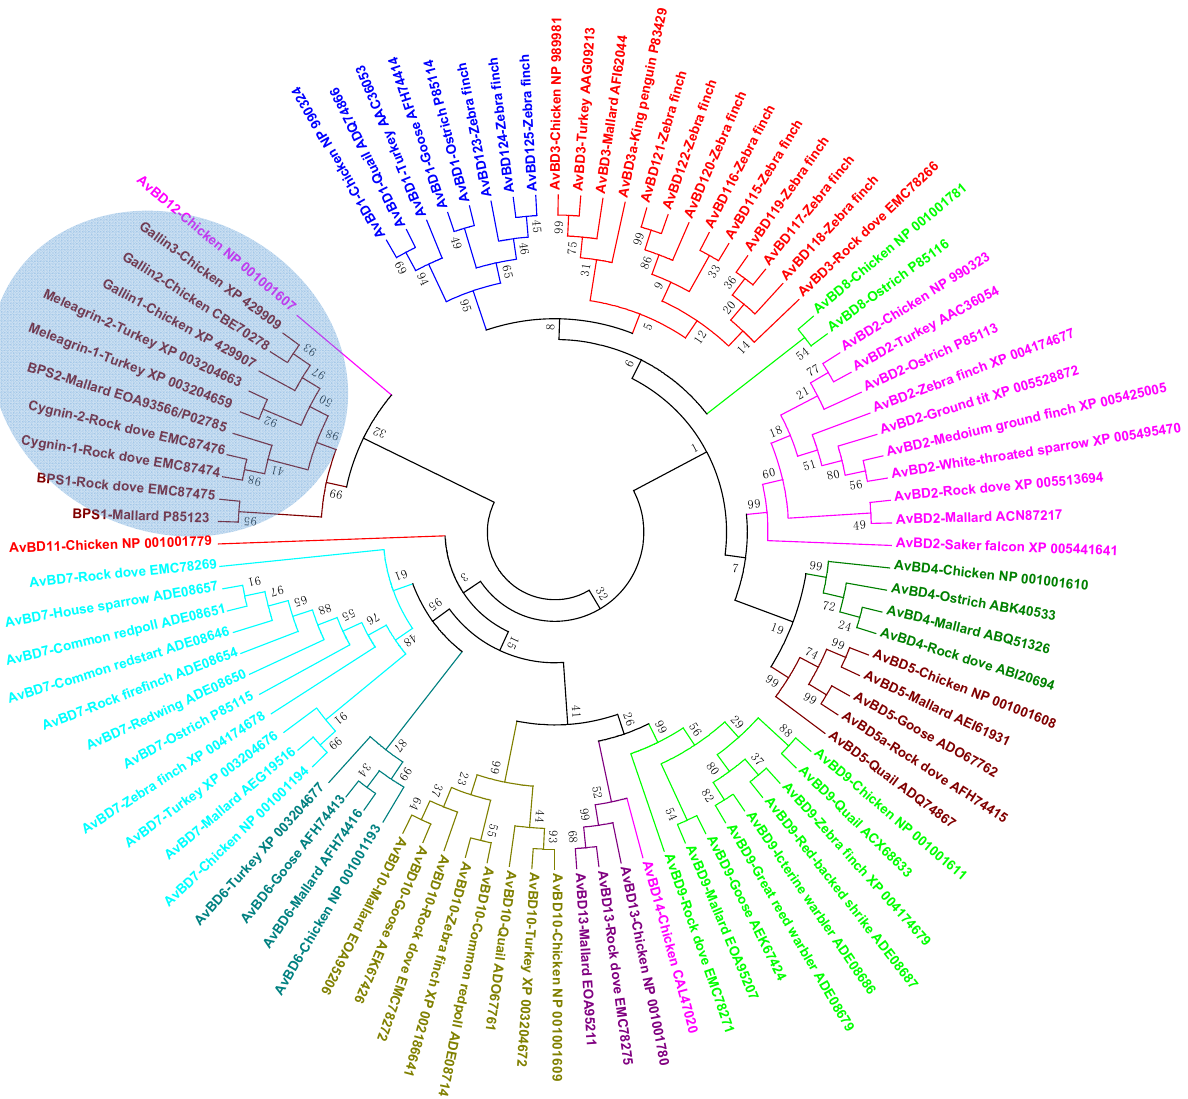
Figure 5. Phylogenetic analysis of avian defensins (see Figure 4 legend for